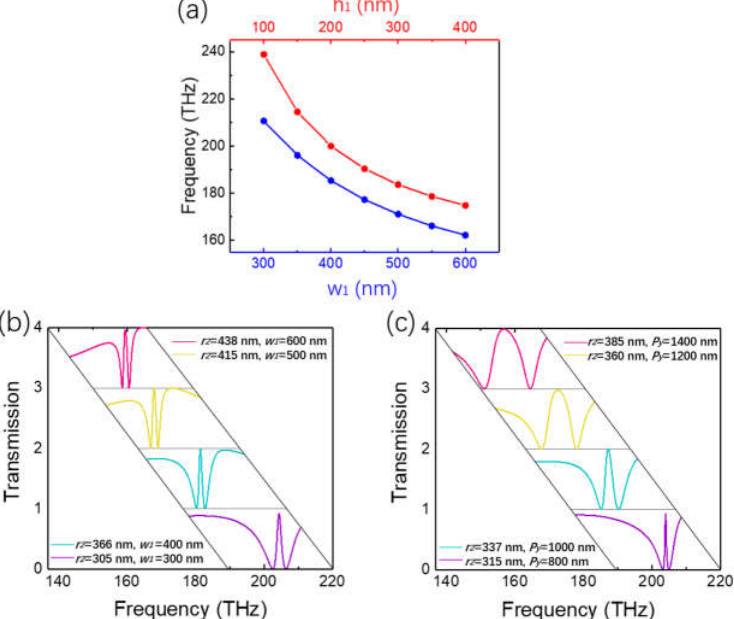
Figure 7. ( a ) Resonance frequencies of the TD-BIC with respect to rod width w 1 when h 1 = 200 nm (blue), and with respect to height h 1 when w 1 = 335 nm (red). ( b ) EIT tuning characteristics obtained by changing disk radius r 2 and rod width w 1 . ( c ) EIT tuning characteristics obtained by changing disk radius r 2 , lattice constant and let P x = P y for simplicity. The thickness t was fixed of 600 nm and h 1 = h 2 = 200 nm.